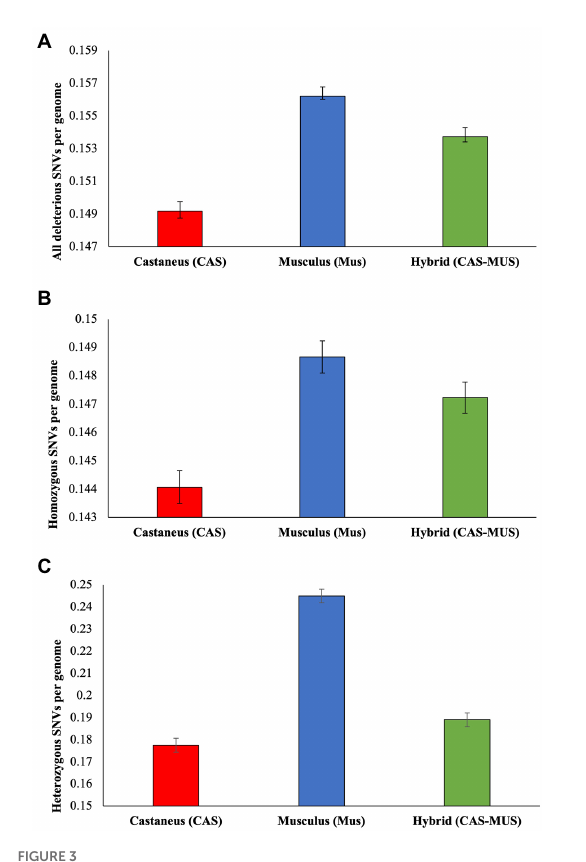
The proportion of deleterious nonsynonymous SNVs (nSNVs) ( δ obs ) computed for M. m. castaneus , M. m. musculus, and admixed populations. (A) All deleterious nSNVs, (B) Homozygous deleterious nSNVs, and (C) Heterozygous deleterious nSNVs. The error bars show the standard error of the mean. The differences between the proportion of deleterious nSNVs of the hybrid and M. m. musculus were significant for all ( p < 0.00001), homozygous ( p < 0.0341), and heterozygous SNVs ( p < 0.00001). Similarly, the differences between the hybrid and M. m. castaneus were also significant for All ( p < 0.00001), homozygous ( p < 0.00001), and heterozygous SNVs ( p <